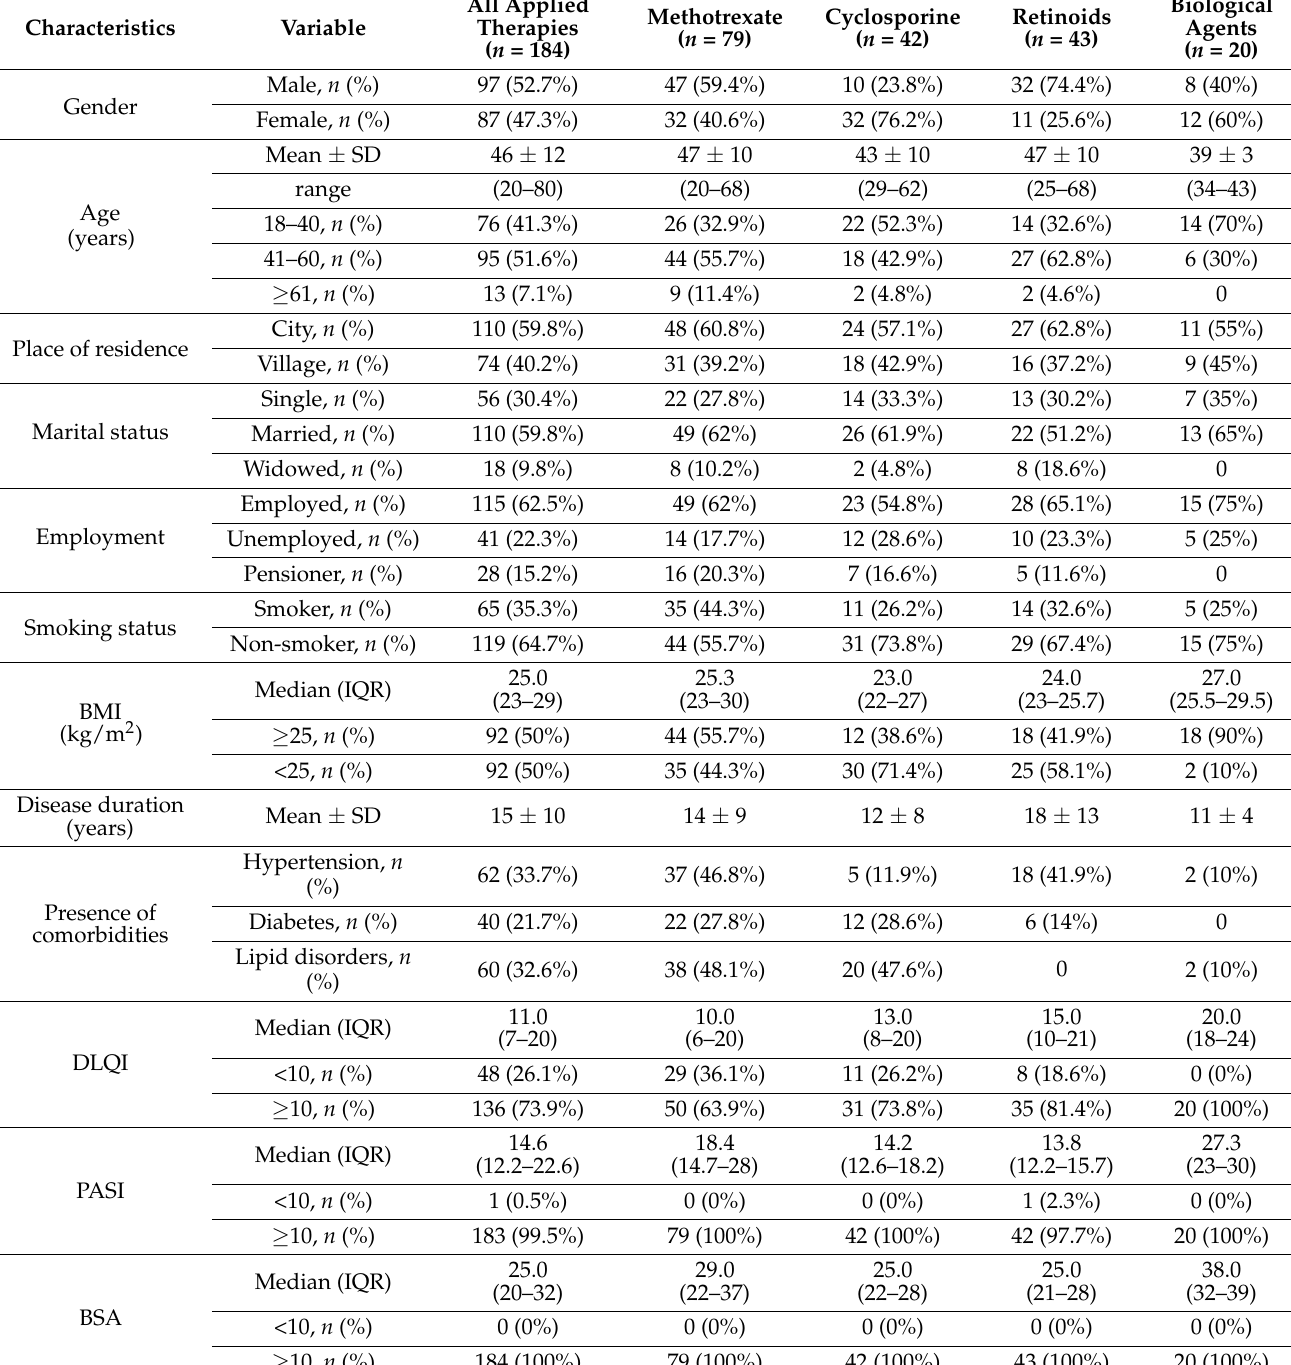
Table 1. Characteristics of the studied psoriatic patients before the treatment with the use of different applied therapies.